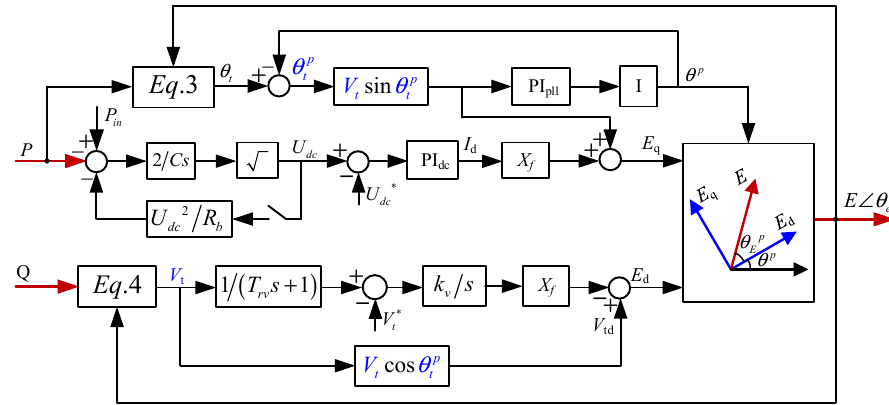
Figure 5. Motion equation model after active power climbing.